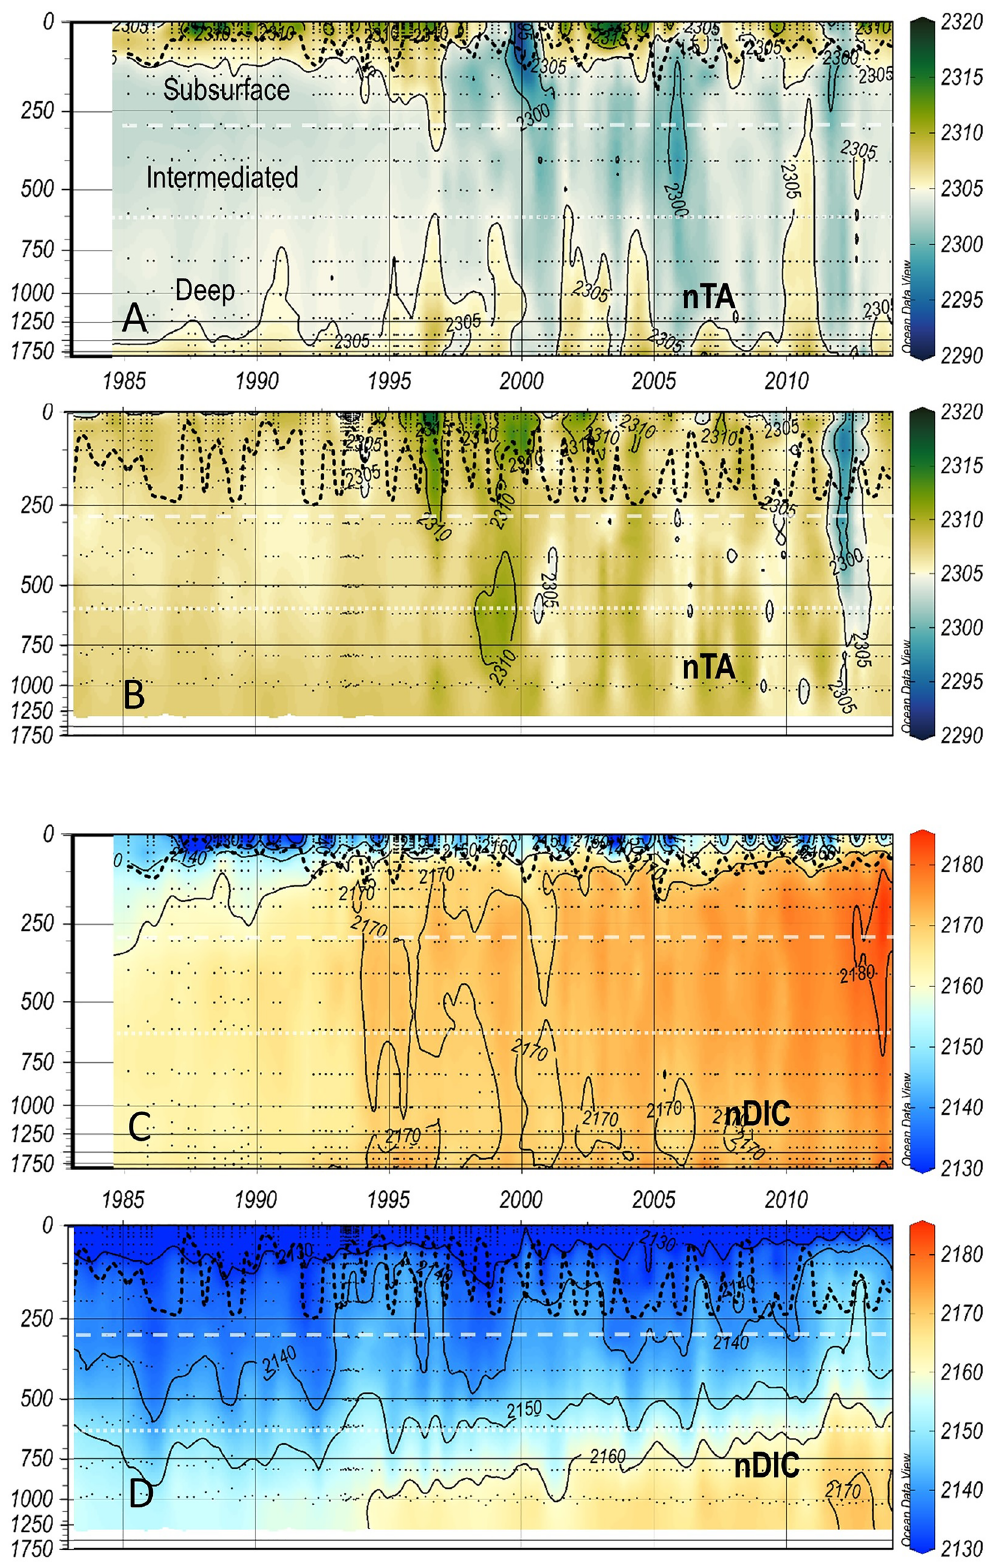
Figure 4. As Fig. 2 for salinity-normalised total alkalinity (nTA) and DIC (nDIC) at IS-TS ( A , C ) and at IRM-TS ( B , D